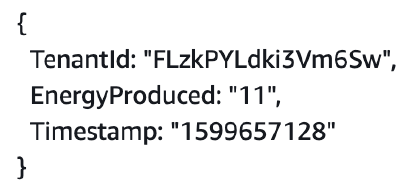
Figure 7. Querying the production of a specific tenant in the ledger.